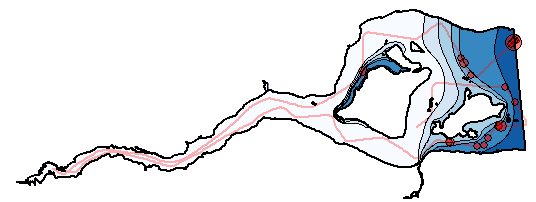
Figure 10. Spatial density surfaces of bowhead abundance in Isabella Bay (PSU14 in the East Baffin Island fjord stratum). Red line: track of aircraft. Red circles: sightings. Darker shading indicates higher predicted density. Estimated surface abundance (uncorrected) was 128